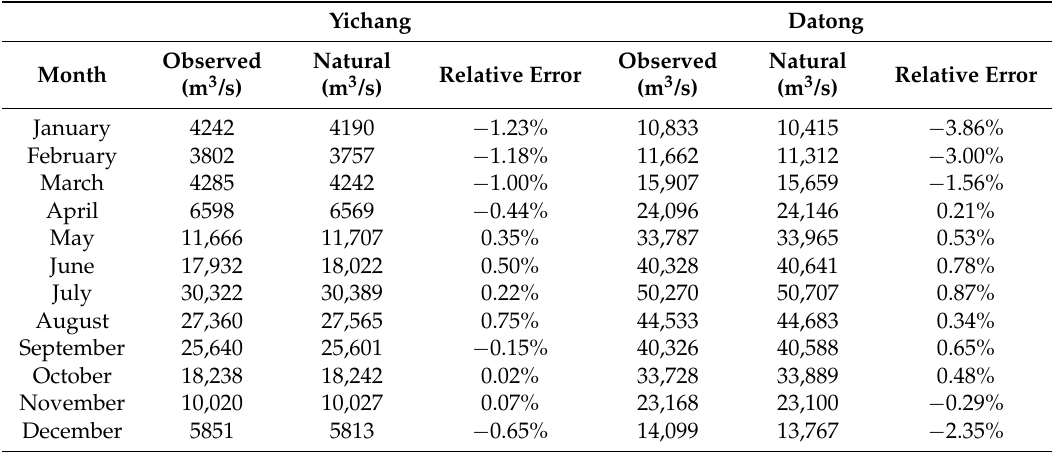
Table 2. Comparison of natural and observed monthly mean discharge during